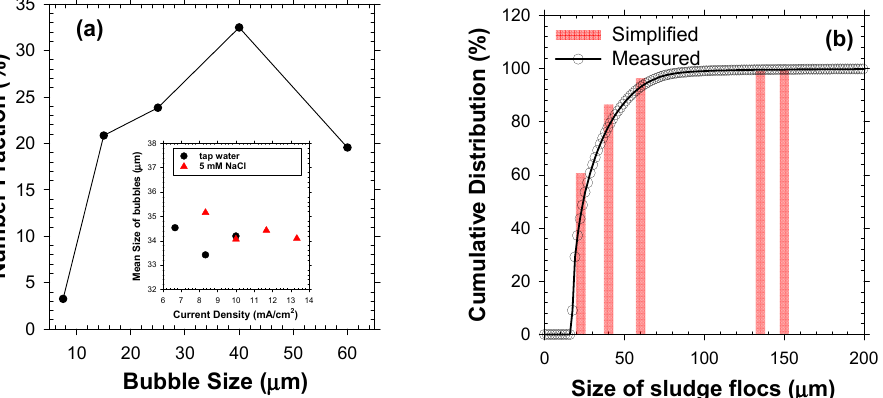
Figure 3. The size distributions of ( a ) electrolytic bubbles in 5 mM of NaCl at j of 10 mA/cm 2 and ( b ) activated sludge flocs in number bases. The inset in ( a ) shows the mean bubble size measured either in tap water or 5 mM of NaCl under j of 6.5–13.5 mA/cm 2 , and the bars in ( b ) depict the simplified particle size distribution.